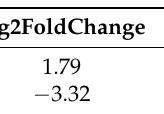
Figure 3. The analysis of differentially expressed miRNAs and cluster analysis by noncoding small RNA next generation sequencing in mouse blood serum extracellular vesicle (EV): ( A ) Venn diagram representing the presence, absence, or overlap of miRNAs identified through NGS in the blood EVs of PBS, ISO and PE infusion mouse; ( B ) The volcano chart of differential expressed miRNAs in ISO versus PBS and PE versus PBS; ( C ) Heat map of hierarchical clustering of differentially expressed miRNAs. PBS ( n = 3), ISO ( n = 3, 10 mg/kg/day) and PE ( n = 3, 30 mg/kg/day) for 1 week. Table 1. miRNAs with significant up-regulation in blood serum extracellular vesicles (EVs) with PE (30 mg/kg/day) infu- sion for 1 week versus PBS. Table 3. miRNAs with significant up and down-regulation in blood serum EVs with ISO (10 mg/kg/day) infusion for 1 week versus